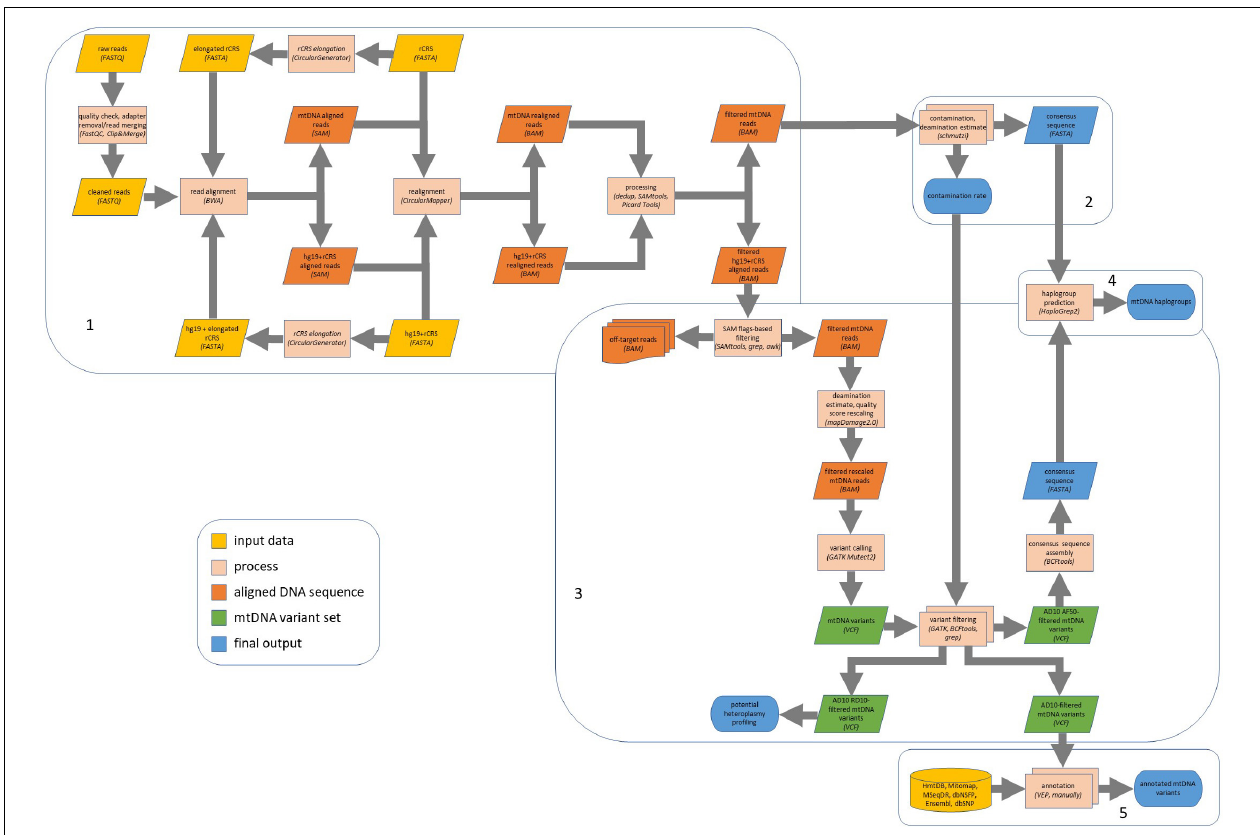
FIGURE 1 | Computational pipeline for ancient mitochondrial DNA (mtDNA) analysis. Our computational pipeline comprises five main steps: (1) read alignment and preprocessing and postprocessing; (2) contamination analysis by schmutzi and consensus sequence assembly; (3) variant calling by GATK Mutect2, variant filtering, and consensus sequence assembly; (4) haplogroup prediction; (5) variant annotation. The alignment required revised Cambridge Reference Sequence (rCRS) as reference sequence to get a suitable input to schmutzi, while we used mtDNA reads aligned onto the whole genome (hg19 with rCRS as a mitochondrial reference sequence) for variant calling. AD10, minimum variant allele depth = 10; AF50, minimum allele fraction = 50%; RD10, minimum reference allele depth =